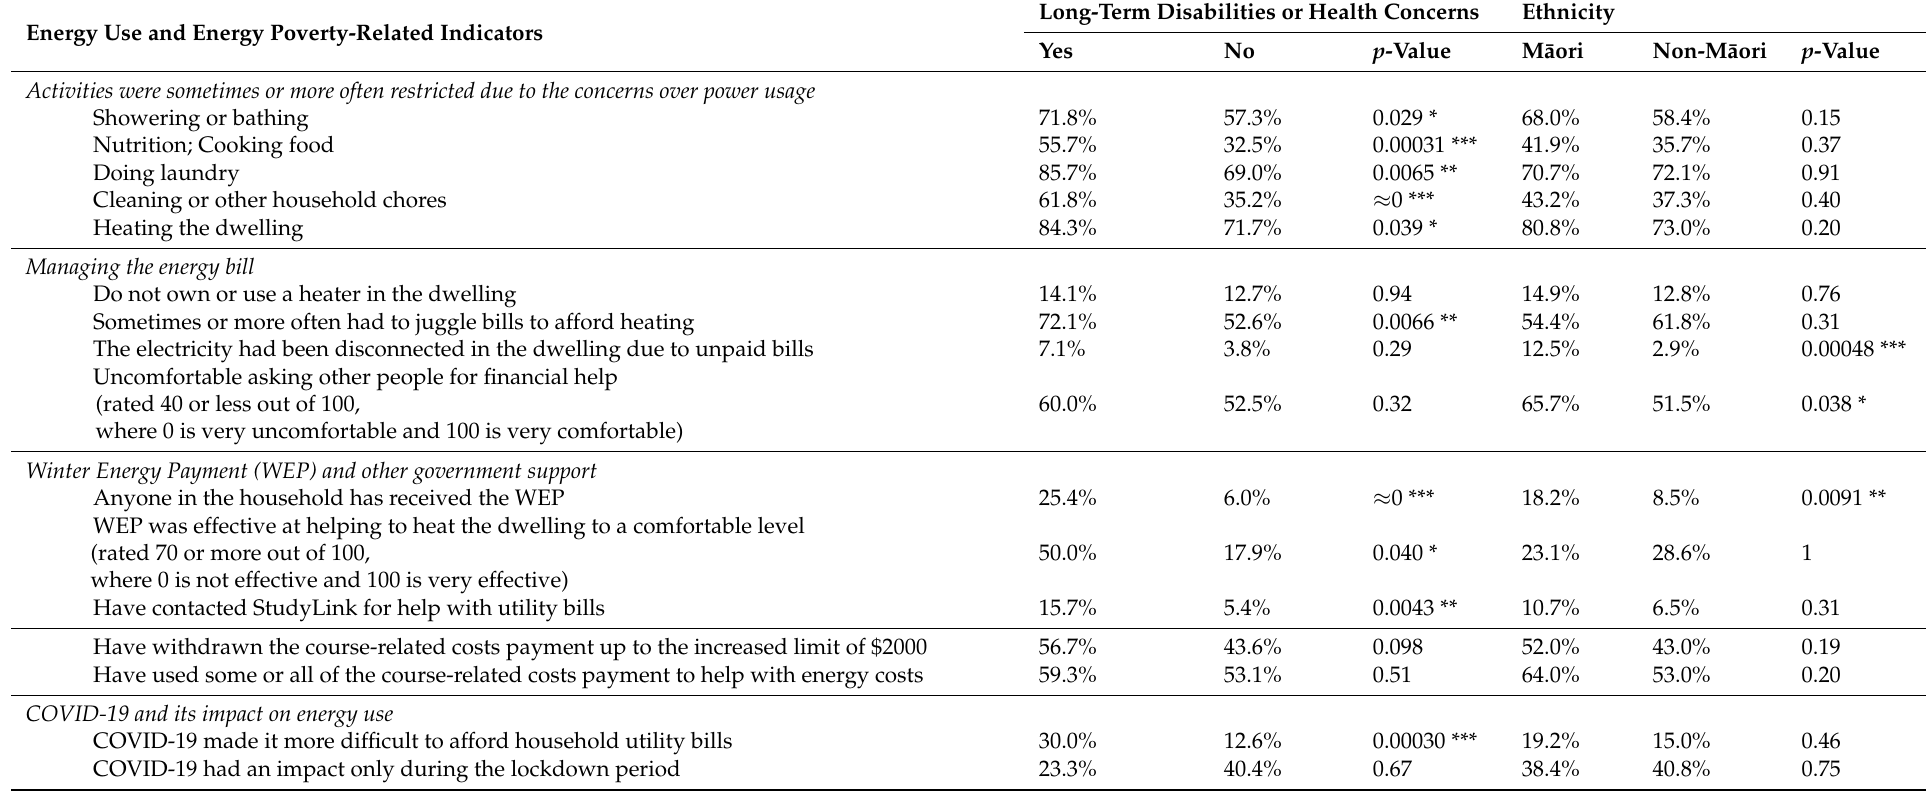
Table 3. Energy use and energy poverty-related indicators compared between demographic